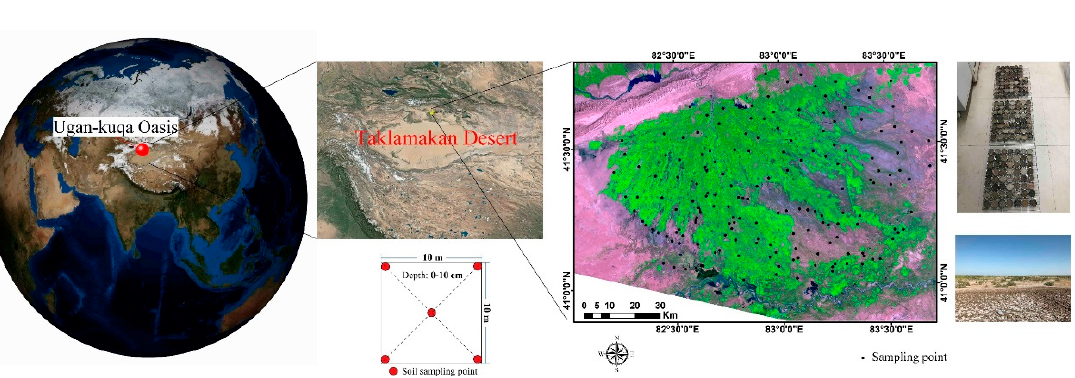
Figure 3. Maps of the study area.